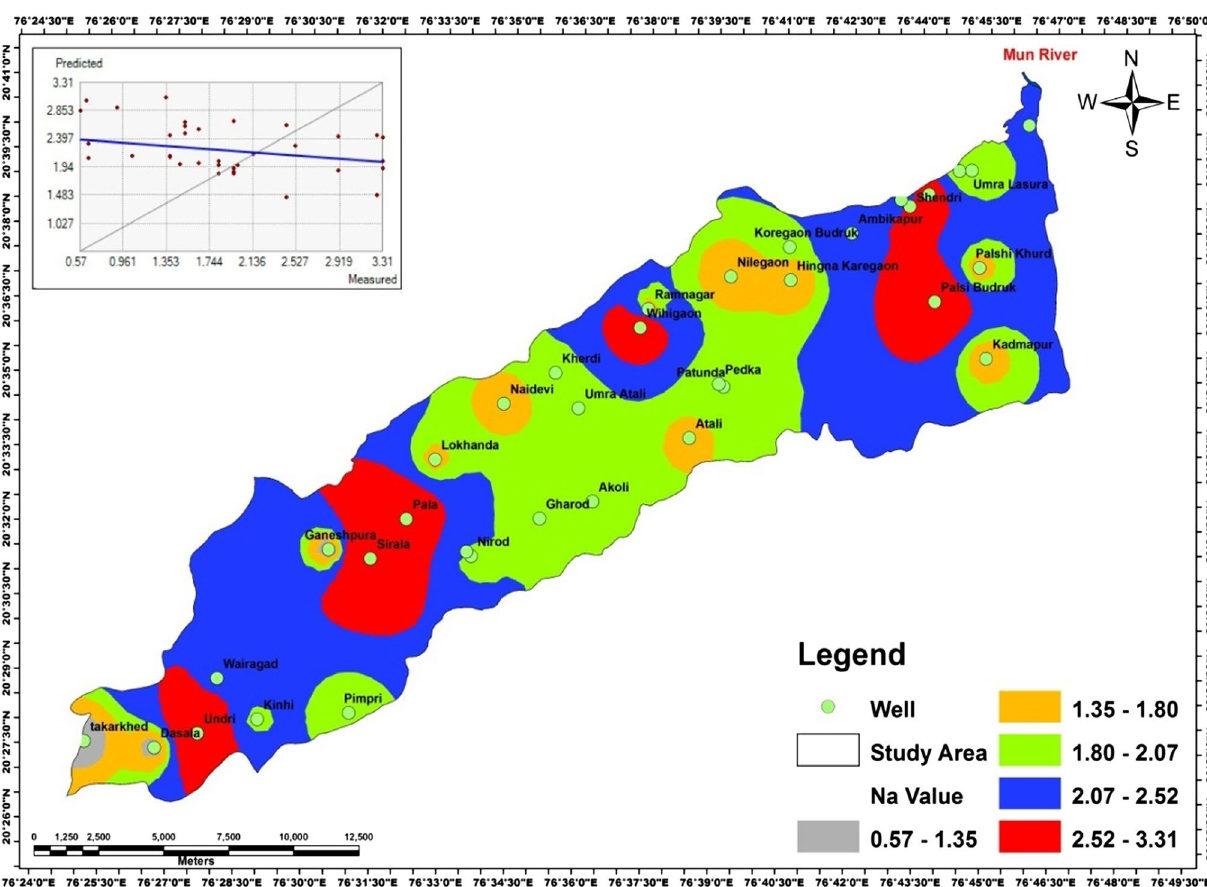
Fig. 9 Spatial distribution map of Na of 2013